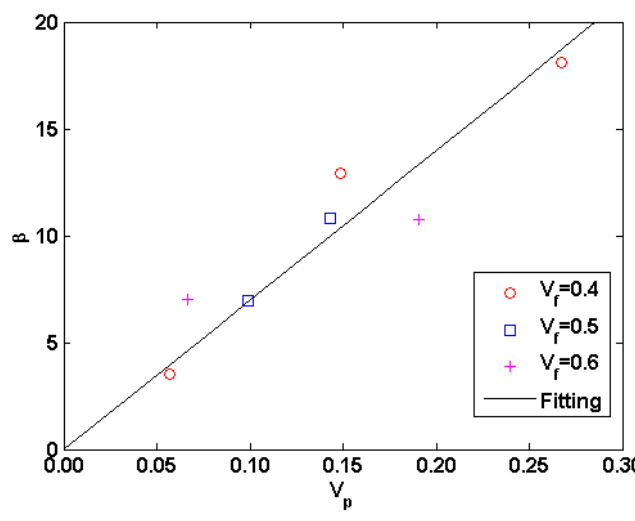
Figure 6. The calculated values of β with porosity for different two-phase systems.